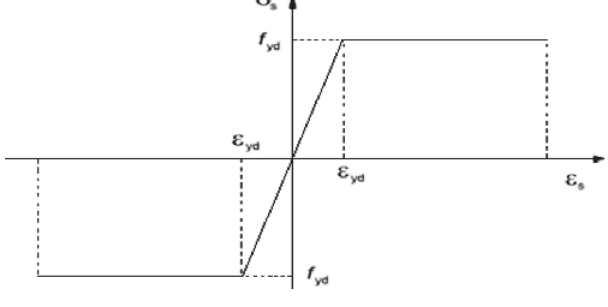
Figura 9 Diagrama tensão-deformação do aço à temperatura ambiente